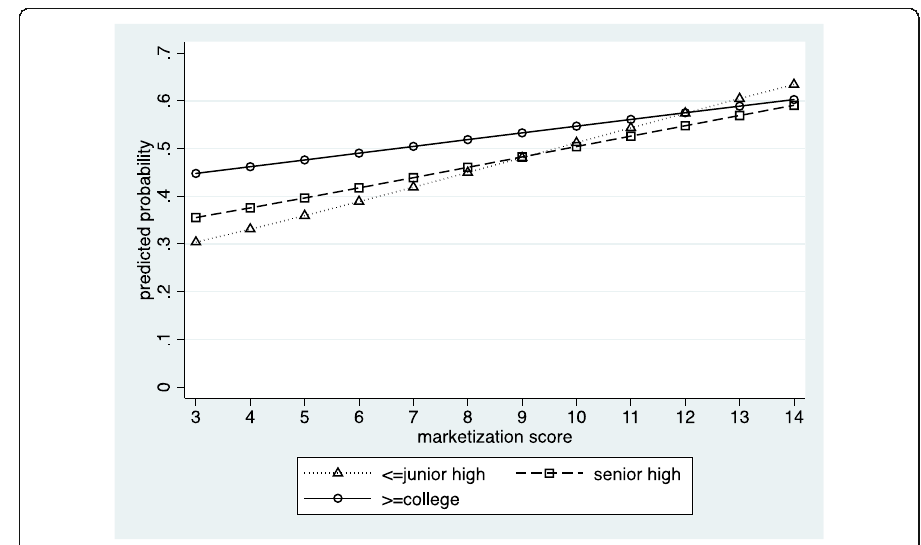
Fig. 2 The predicted probability of viewing guanxi as unfair (versus neutral), by marketization score and educational attainment